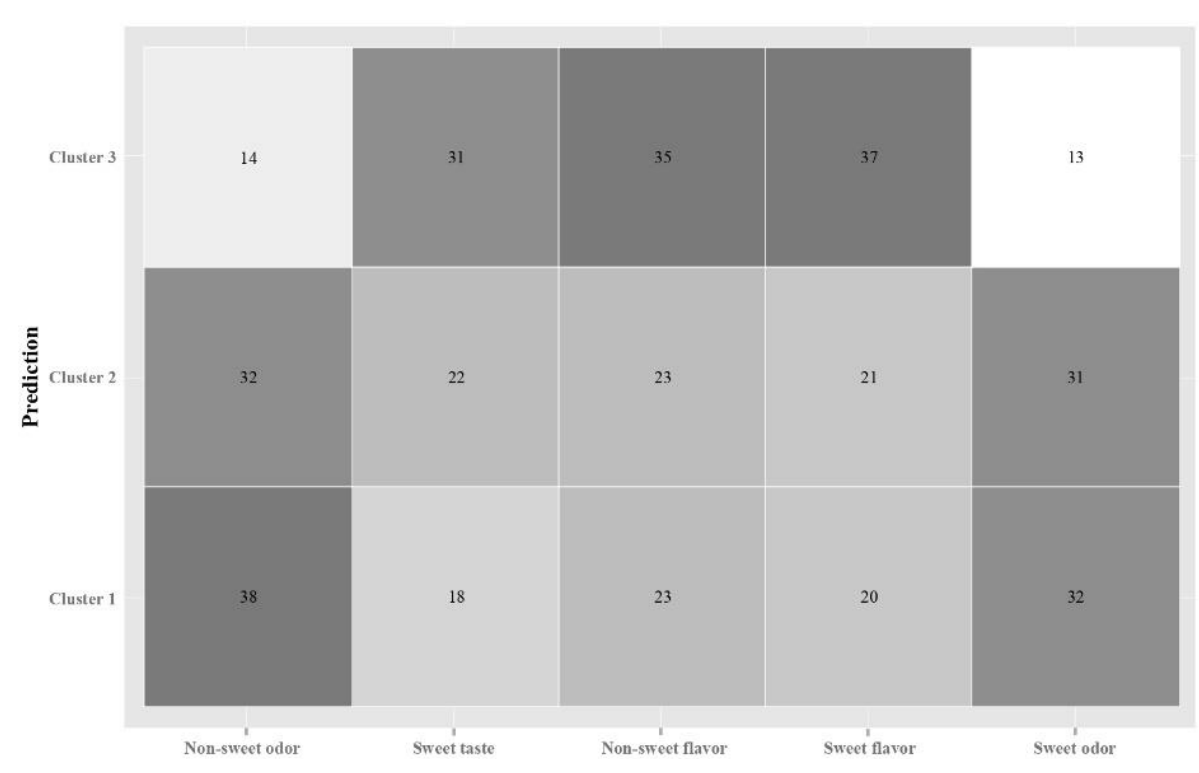
Figure 3. Confusion matrix of clusters and epochs.